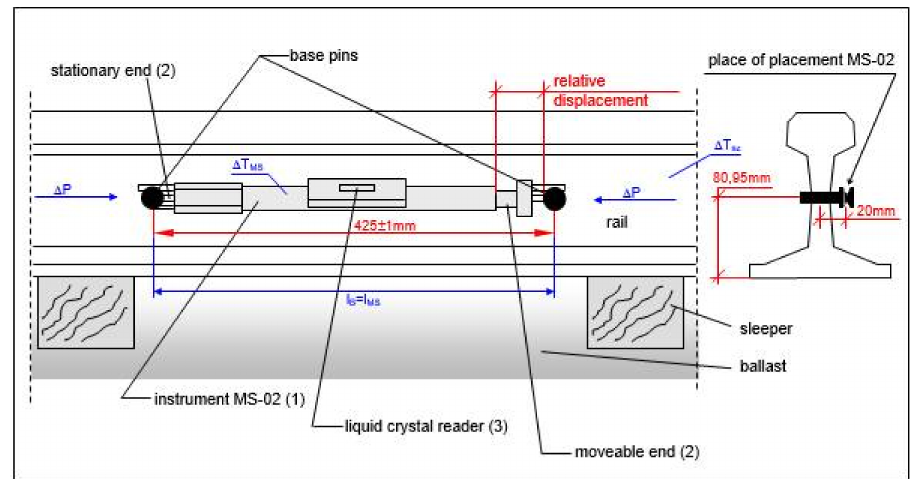
Figure 8. MS-02 Longitudinal force gauge—components (source: own work).